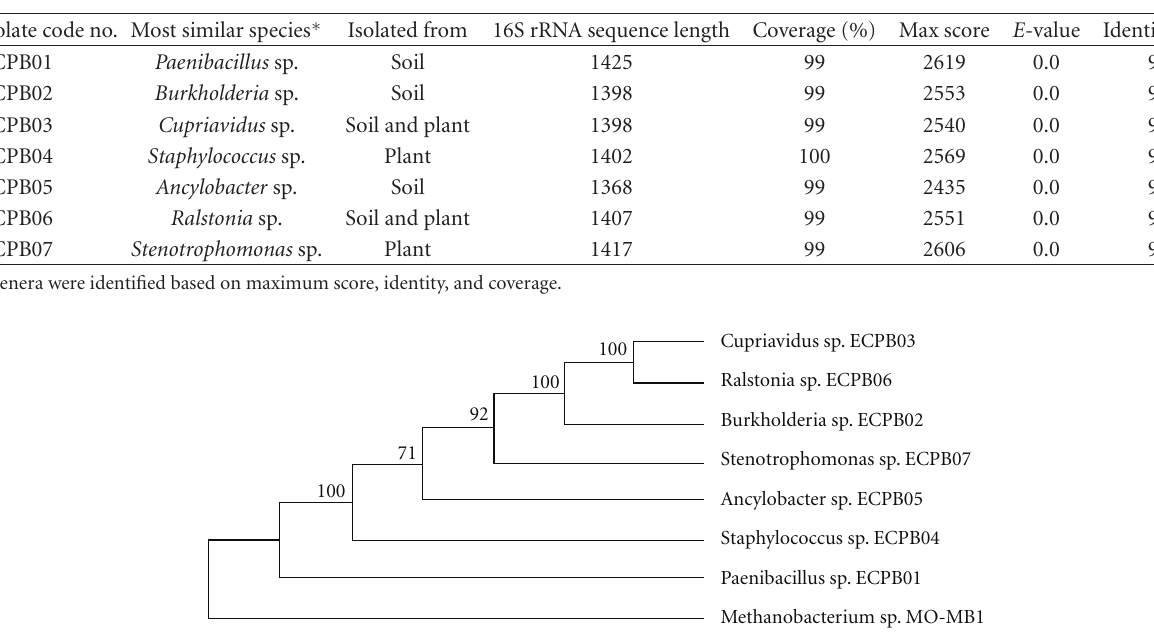
Figure 1: Phylogenetic tree based on 16S rRNA sequences by Maximum Parsimony analysis. ECPB01 to ECPB07 represent the isolate code and Methanobacterium sp. MO-MB1 (gi | 311141366 | dbj | AB598270.1 | ) the outgroup. The evolutionary history was inferred using the Maximum Parsimony method. The bootstrap consensus tree inferred from 1000 replicates is taken to represent the evolutionary history of the taxa analyzed. Branches corresponding to partitions reproduced in less than 50% bootstrap replicates are collapsed. The percentage of replicate trees in which the associated taxa clustered together in the bootstrap test (1000 replicates) is shown next to the branches. The